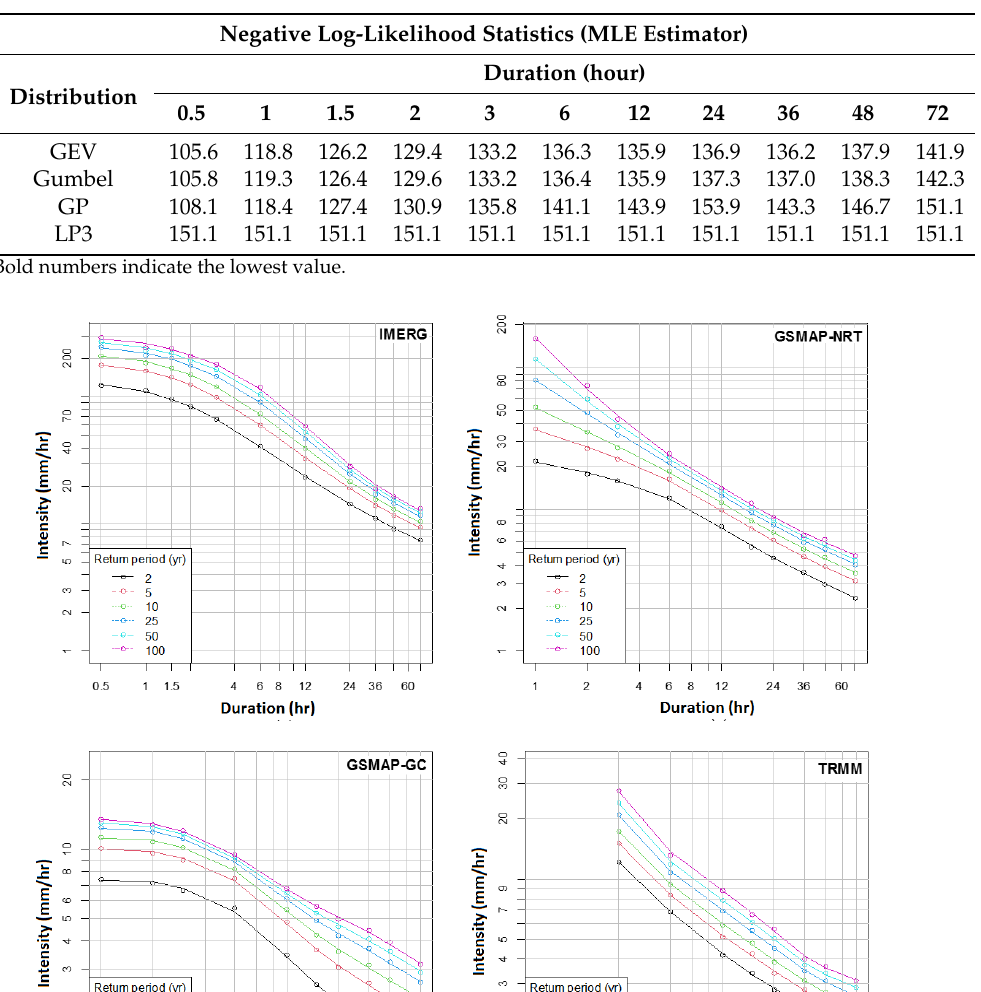
Table 5. Negative log-likelihood values for Yangon International Airport (YIA).